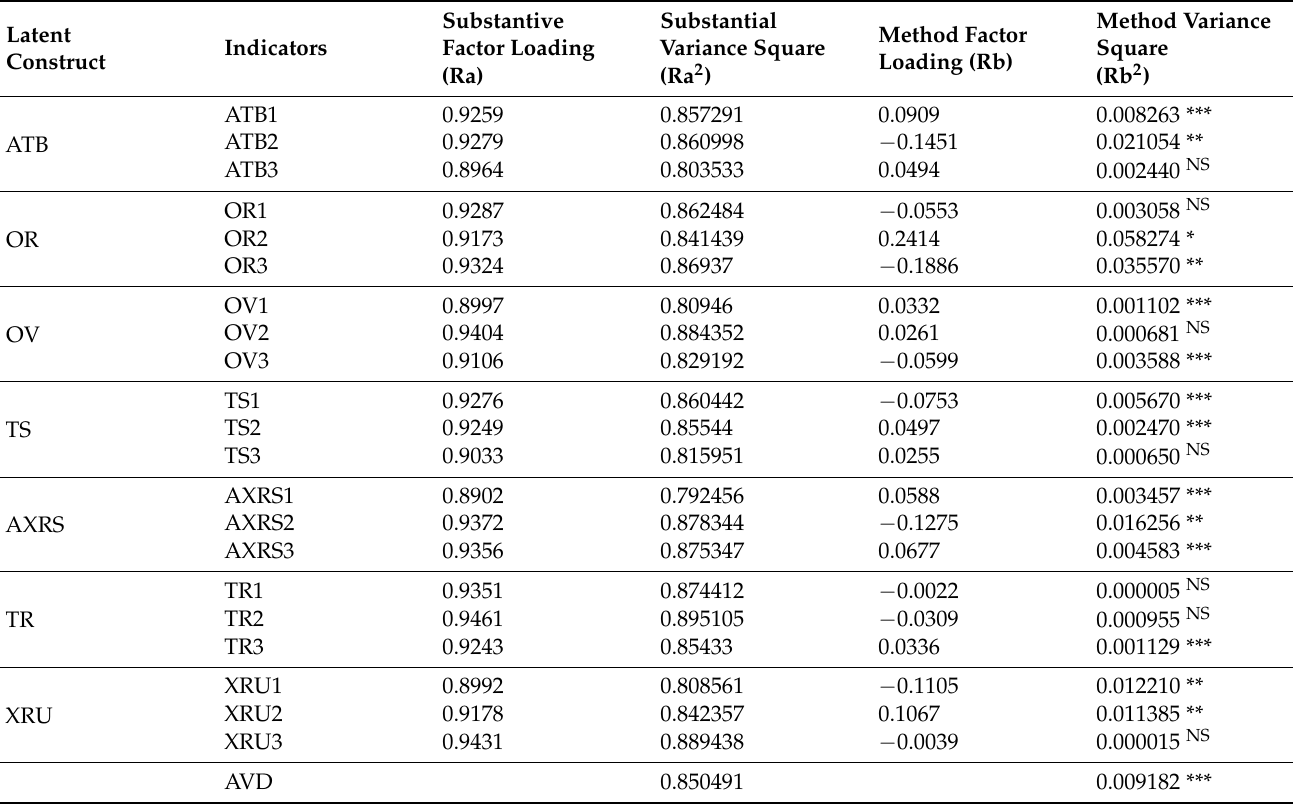
Table 2. Common-method bias